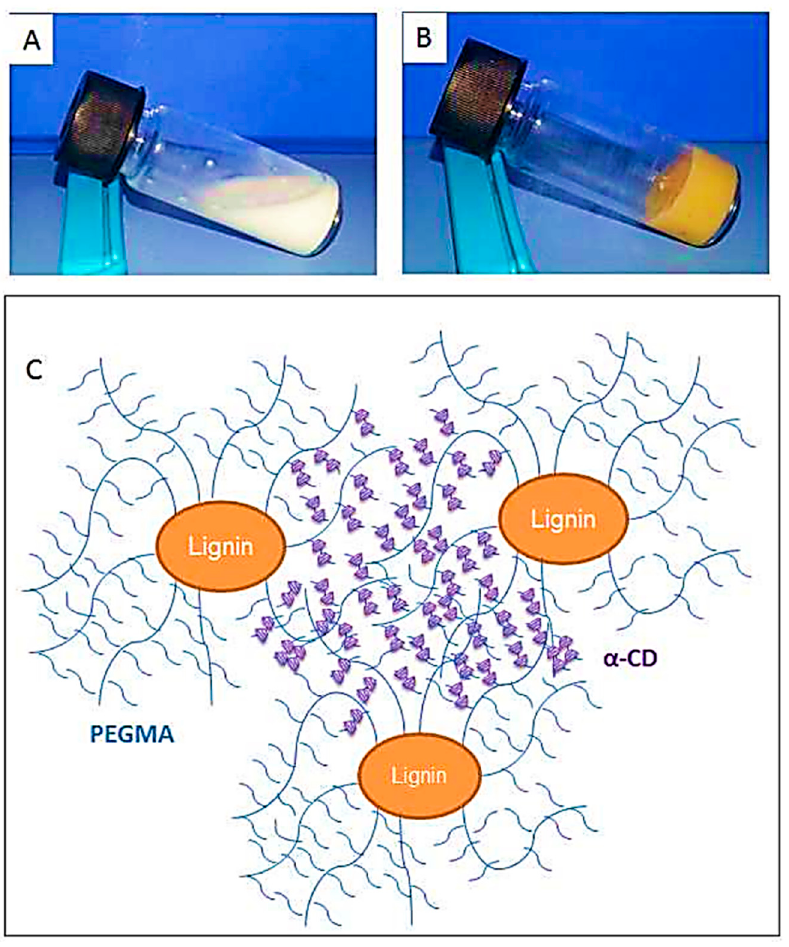
Figure 23. Lignin-based supramolecular hydrogel by inclusion complexation between PEGMA- grafted lignin and α -CD. Reproduced with permission [79].